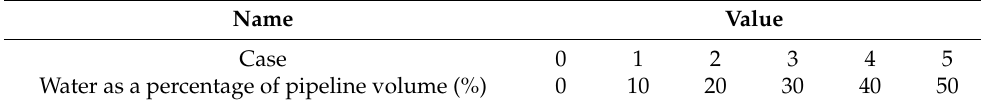
Table 2. Different experimental cases with different volume percentage of water.